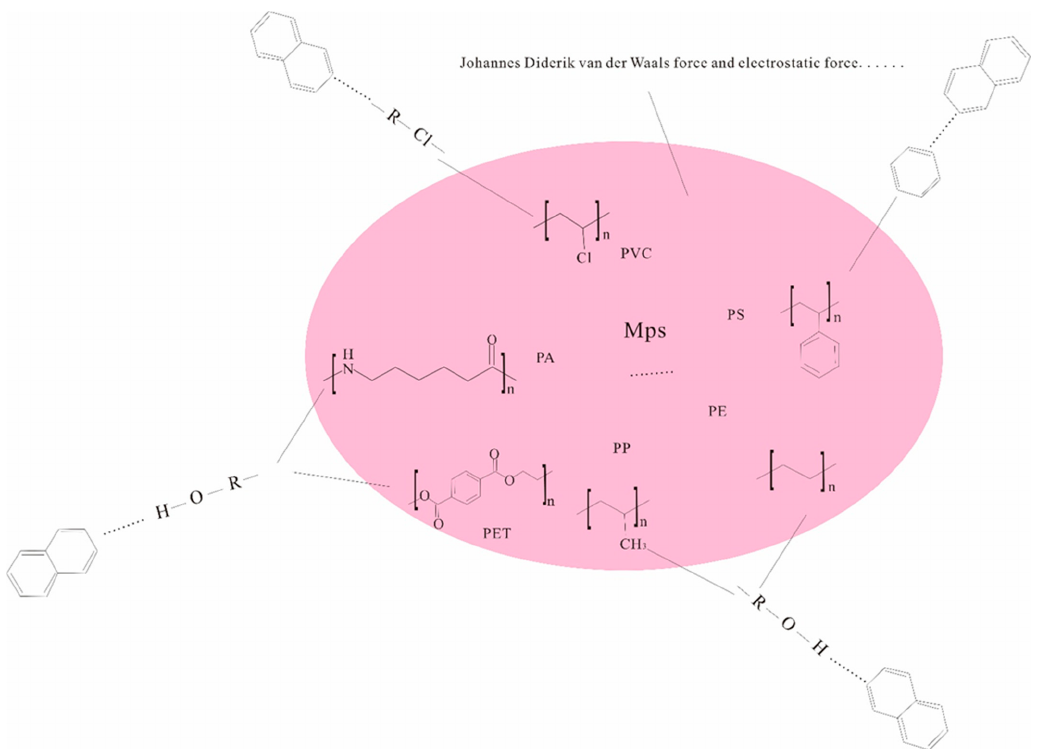
Figure 5. The main mechanism of interaction between MPs and